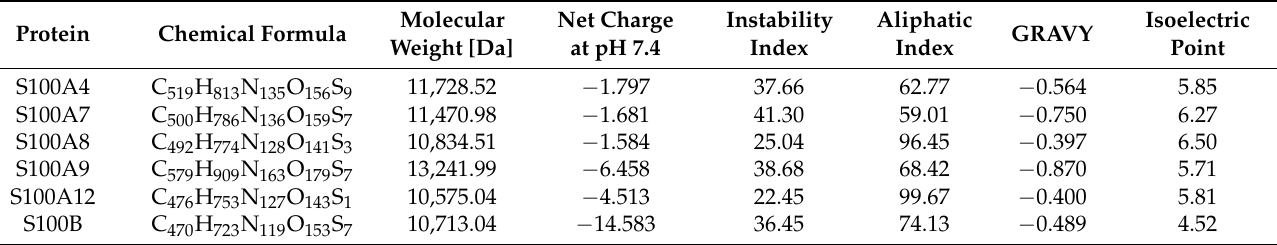
Table A1. Chemical and physical properties of selected S100 proteins computed using ProtParam [259] and Prot pi tools [277] including molecular weight, theoretical pI, atomic composition, instability index, aliphatic index, net charge at pH 7.4, and grand average of hydropathicity (GRAVY).